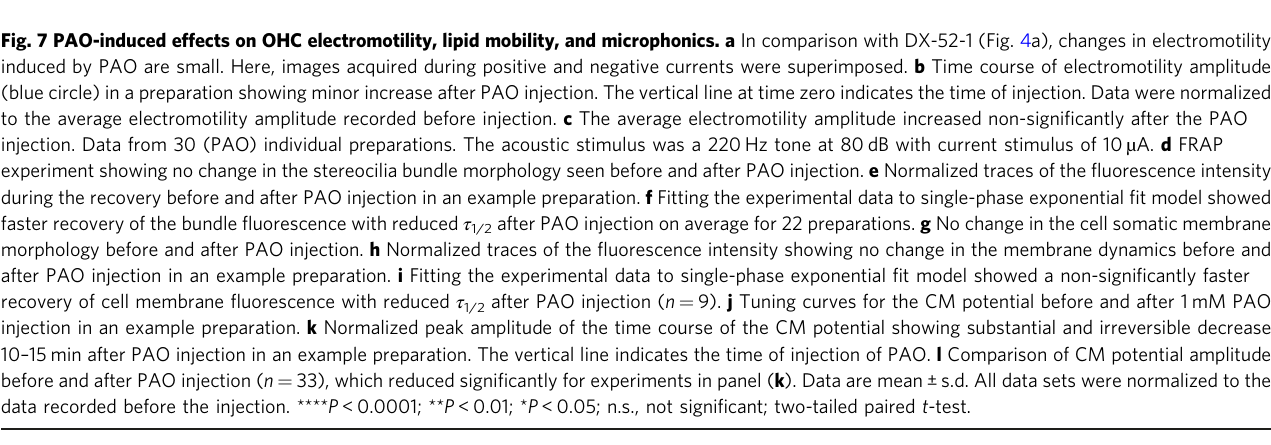
Fig. 7 PAO-induced effects on OHC electromotility, lipid mobility, and microphonics. a In comparison with DX-52-1 (Fig. 4a), changes in electromotility induced by PAO are small. Here, images acquired during positive and negative currents were superimposed. b Time course of electromotility amplitude (blue circle) in a preparation showing minor increase after PAO injection. The vertical line at time zero indicates the time of injection. Data were normalized to the average electromotility amplitude recorded before injection. c The average electromotility amplitude increased non-signi fi cantly after the PAO injection. Data from 30 (PAO) individual preparations. The acoustic stimulus was a 220Hz tone at 80 dB with current stimulus of 10 µ A. d FRAP experiment showing no change in the stereocilia bundle morphology seen before and after PAO injection. e Normalized traces of the fl uorescence intensity during the recovery before and after PAO injection in an example preparation. f Fitting the experimental data to single-phase exponential fi t model showed faster recovery of the bundle fl uorescence with reduced τ 1/2 after PAO injection on average for 22 preparations. g No change in the cell somatic membrane morphology before and after PAO injection. h Normalized traces of the fl uorescence intensity showing no change in the membrane dynamics before and after PAO injection in an example preparation. i Fitting the experimental data to single-phase exponential fi t model showed a non-signi fi cantly faster recovery of cell membrane fl uorescence with reduced τ 1/2 after PAO injection ( n = 9). j Tuning curves for the CM potential before and after 1 mM PAO injection in an example preparation. k Normalized peak amplitude of the time course of the CM potential showing substantial and irreversible decrease 10 – 15 min after PAO injection in an example preparation. The vertical line indicates the time of injection of PAO. l Comparison of CM potential amplitude before and after PAO injection ( n = 33), which reduced signi fi cantly for experiments in panel ( k ). Data are mean ± s.d. All data sets were normalized to the data recorded before the injection. **** P < 0.0001; ** P < 0.01; * P < 0.05; n.s., not signi fi cant; two-tailed paired